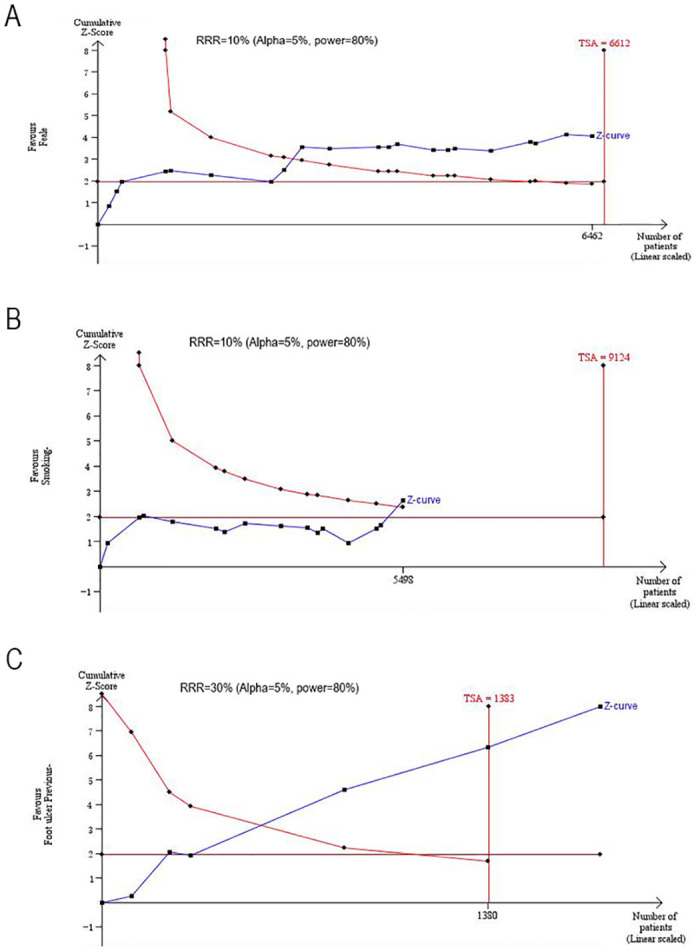
TSA results of the related risk factors.(A) Sex; (B) Smoking history; (C) History of foot ulcers. The information size was calculated based on relative risk reduction (RRR), alpha of 5%, power of 80%.